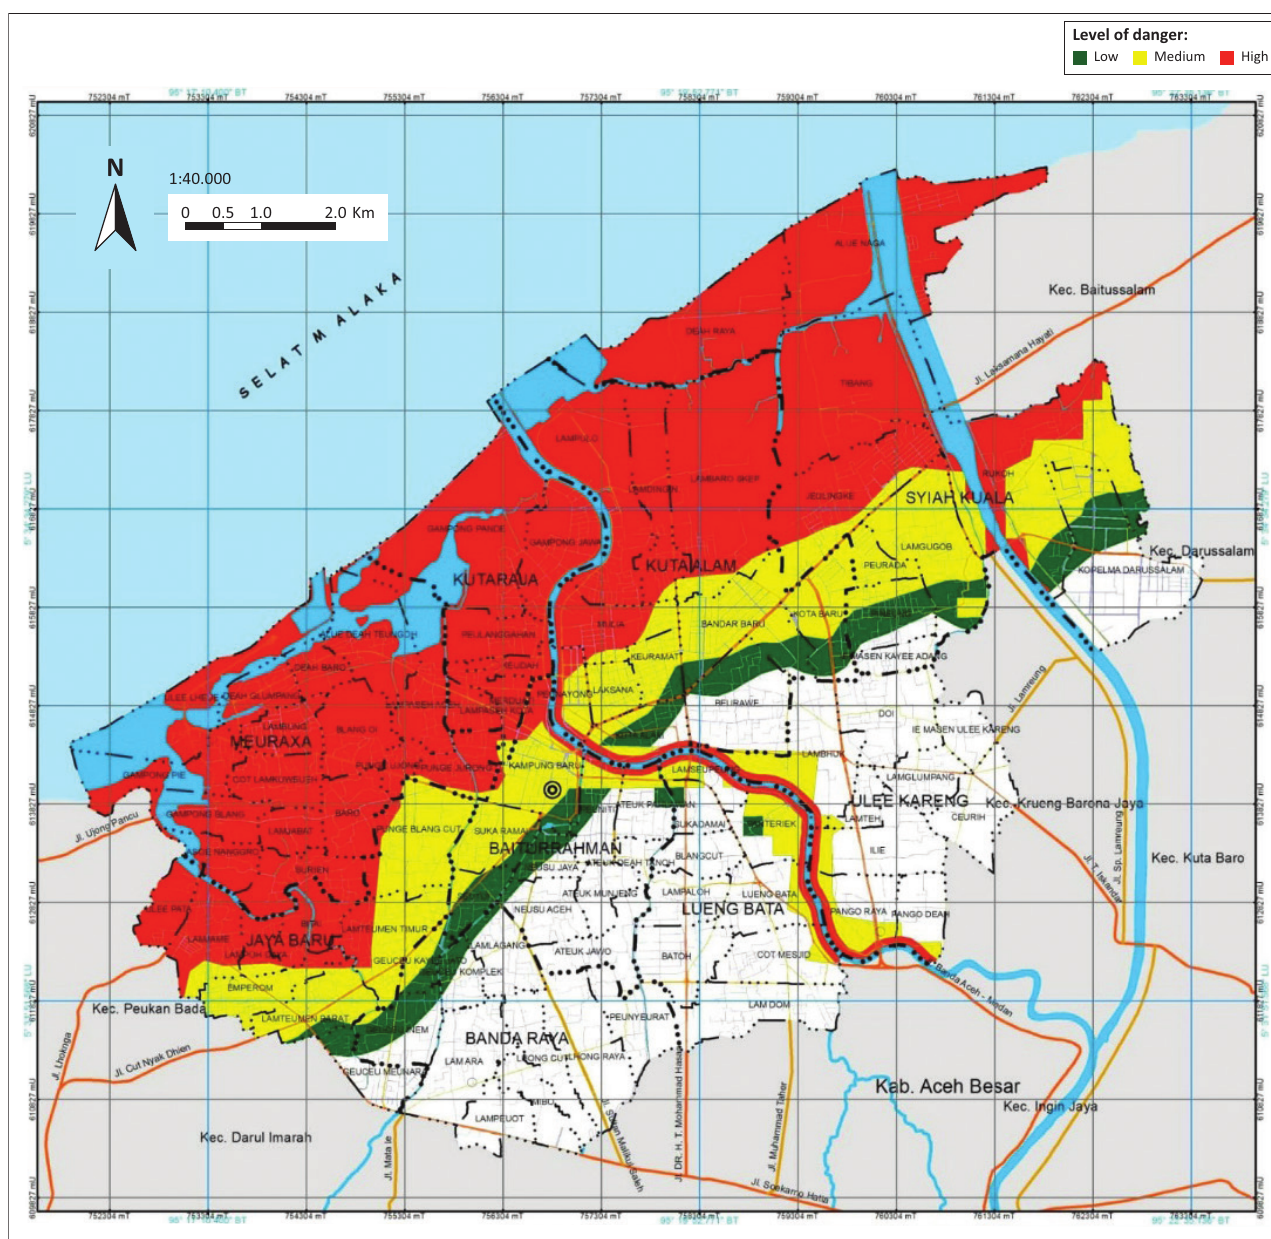
FIGURE 1: Location of the data